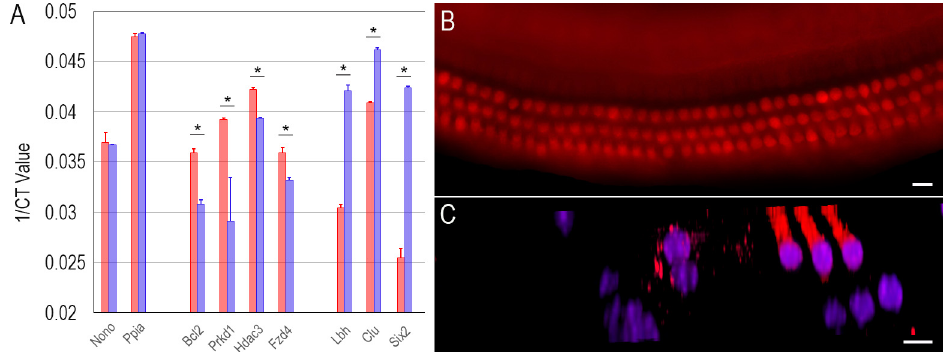
Fig 7. Validation of gene expression by qPCR and immunocytochemistry. (A) Comparison of seven TF genes expressed in adult IHCs and OHCs using qPCR. Note that the ordinate is the inverse of the number of PCR cycles necessary to reach fluorescence threshold. So even a small change (such as 0.01) reflects a large difference. The asterisk represents statistical significance (p < 0.001, Student ’ s t-test) between each pair. (B) Fluorescence image of expression of LBH in the adult organ of Corti. (C) Optical sectioning of the organ of Corti using confocal microscopy. Nuclei were labelled with DAPI. Bar represents 10 μ